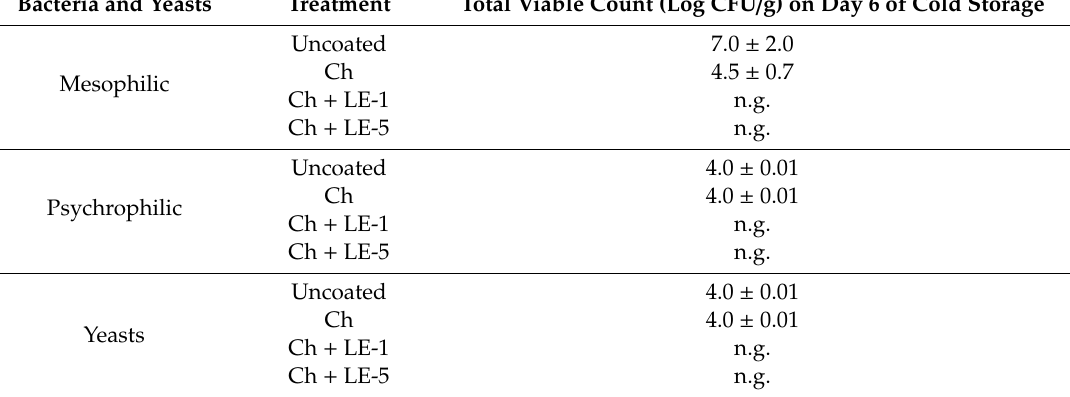
Table 7. E ff ects of edible coatings prepared with chitosan and chitosan + licorice extract on the growth of mesophilic and psychrophilic bacteria (total aerobic psychrophilic bacteria) and yeasts during storage at 4 ◦ C. Ch = Chitosan; Ch + LE-1 = Chitosan + 1% of licorice extract; Ch + LE-5 = Chitosan + 5% of licorice